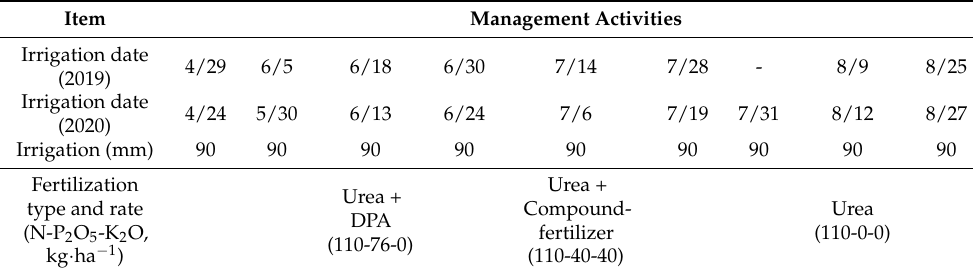
Table 2. Irrigation and fertilization